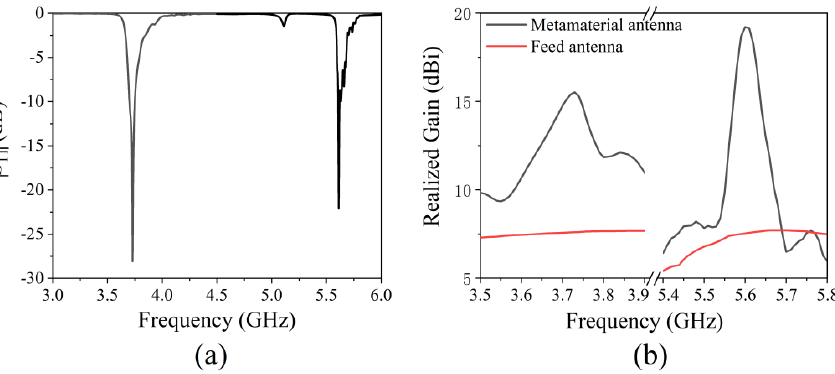
Figure 13. Measured ( a ) return loss (|S 11 |) and ( b ) realized gain of the metamaterial antenna.